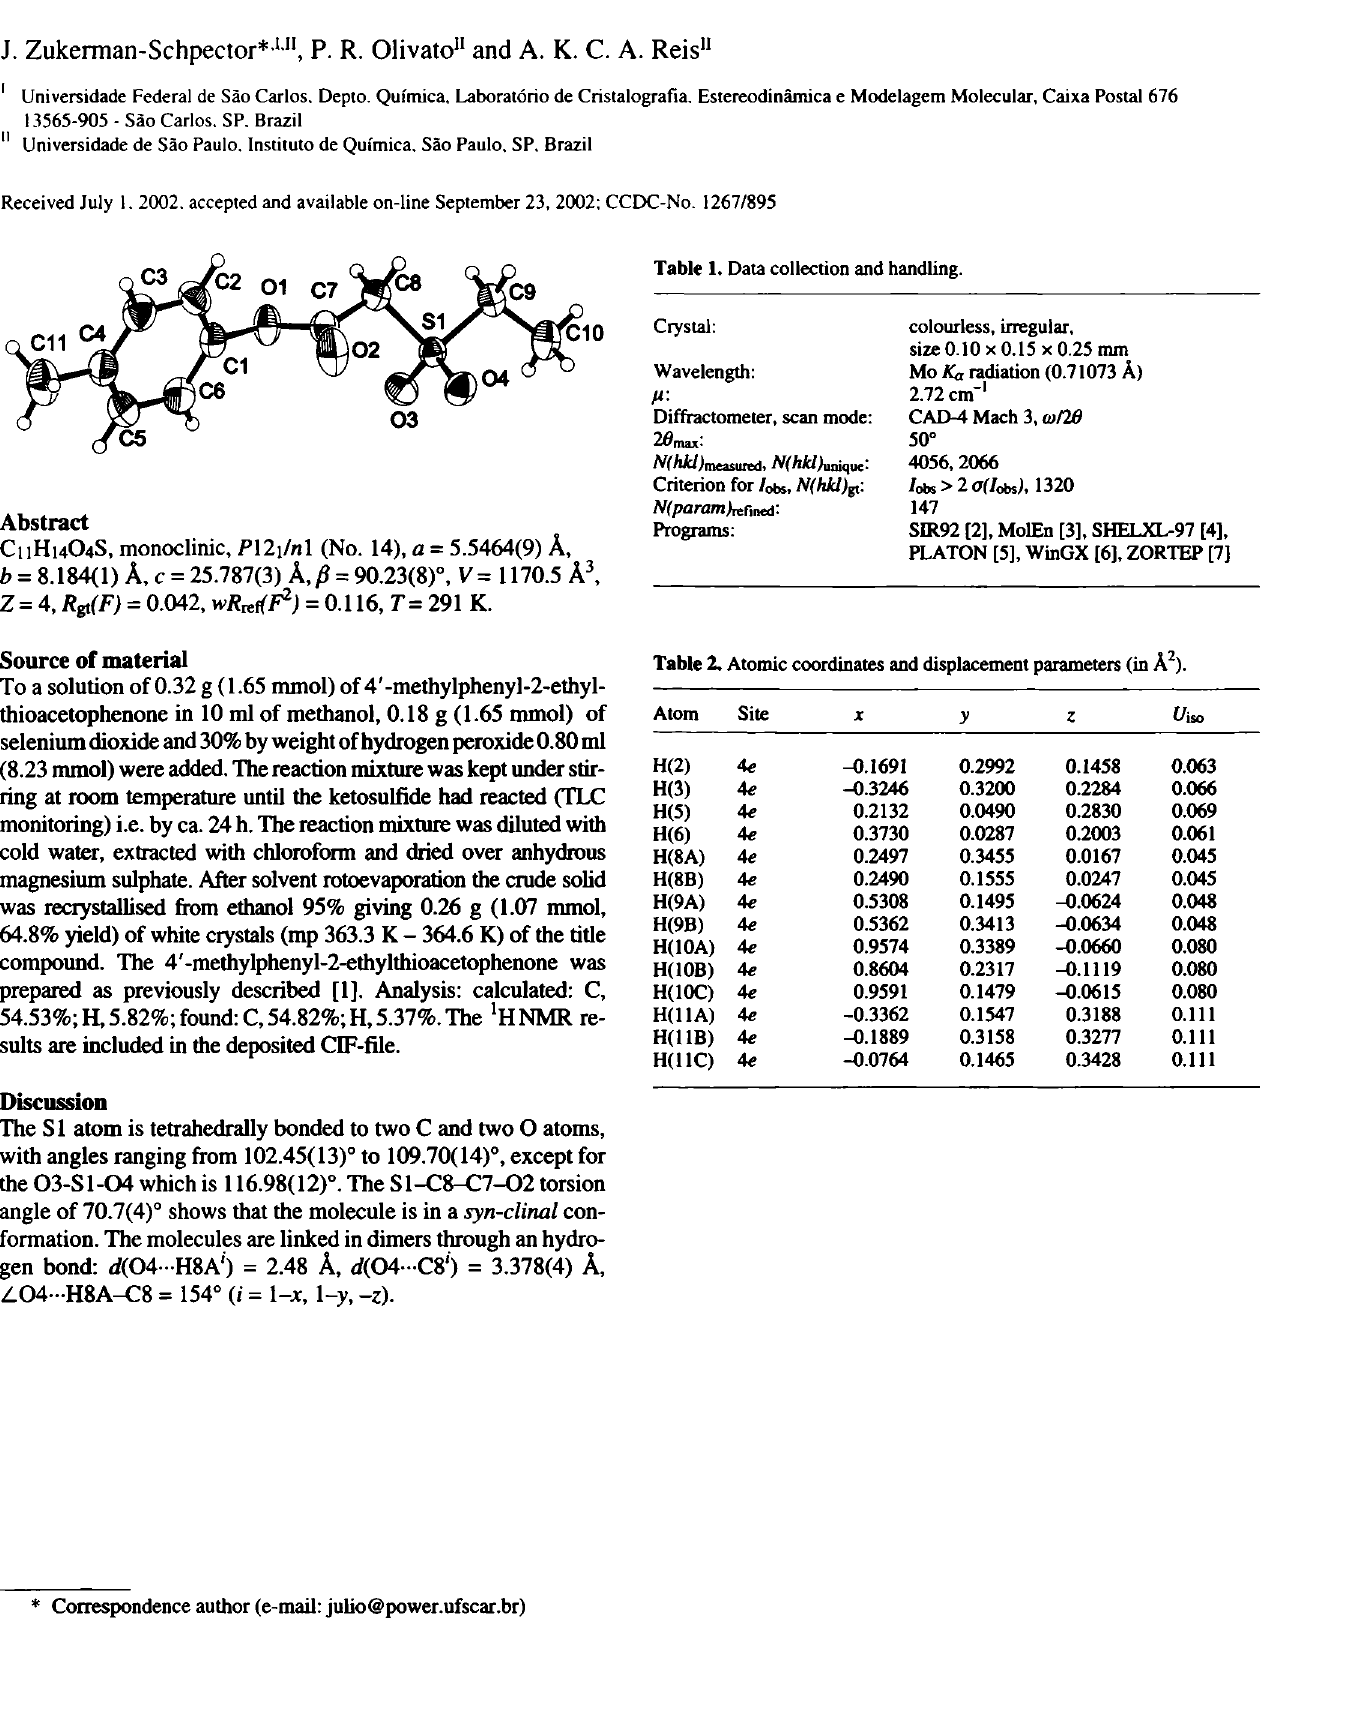
Table 1. Data collection and handling.